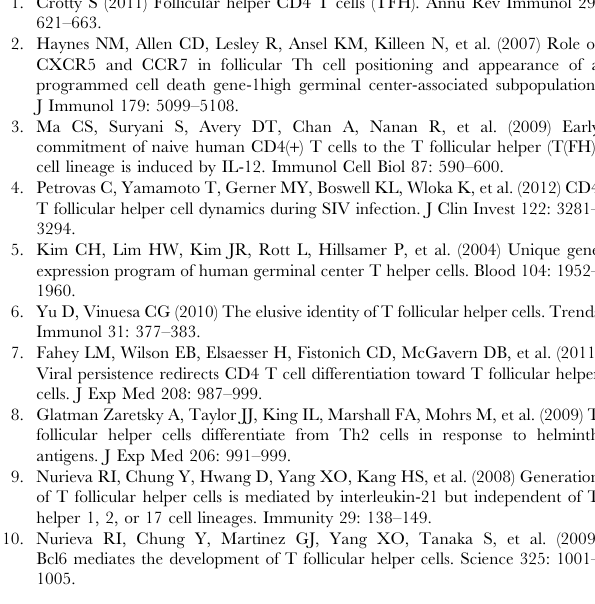
showing the frequency (%) of indicated populations in CXCR5- expressing cells from PBMC from HIV-uninfected subjects (open circles; n =13) and HIV-infected subjects before (n =14, week 0; black circles) and after ART (week 24, dark gray circles; week 48, light gray circles). Figure S3 Characterization of pT FH cells in HIV infec- tion. ( A ) CCR7 high CXCR5 low and CCR7 high CXCR5 high CCR6 high CD4 T cells isolated from PBMCs were cultured with autologous naı¨ve B cells (CD19 high CD27 low IgD 2 ) in the presence of SEB for 2 days and cytokine concentrations were measured from supernatants (HIV-uninfected, n=5; HIV-infected (non-viremic), n=4, HIV- infected (viremic), n=0–1). Due to limited cell numbers we were unable to collect CCR7 high CXCR5 high CCR6 high cells from viremic individuals. ( B ) Sorted CXCR5 high central memory cells isolated from blood do not down-regulate surface expression of CXCR5 upon X4 or R5 in vitro infection. Table S1 CD4 count, viral load and neutralization activity of subjects